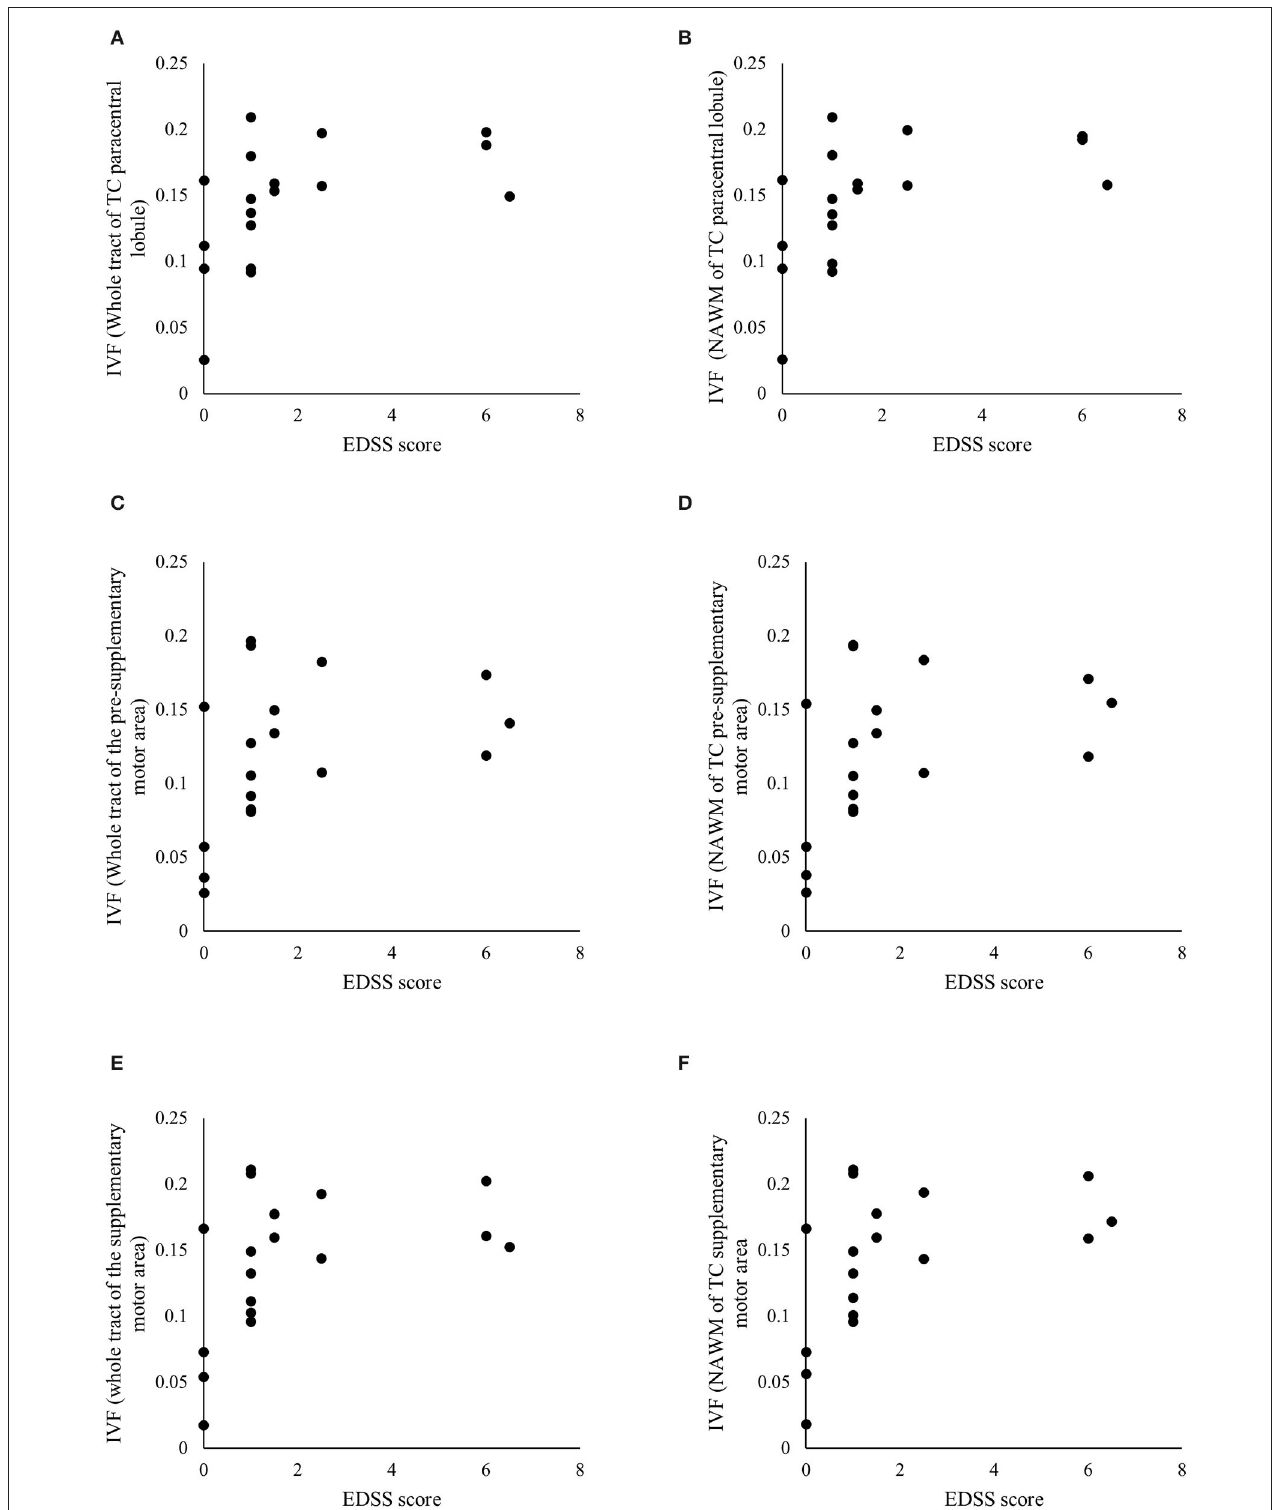
FIGURE 5 | Significant associations between clinical and radiological measures. Scatterplots of the Expanded Disability Status Scale (EDSS) scores and the isotropic volume fraction (IVF) values measured in the whole tract and normal appearing white matter (NAWM) of the transcallosal (TC) paracentral lobule (A,B) , TC pre-supplementary motor area (C,D) , and TC supplementary motor area (E,F) . Table 3 details p- and rho -values.